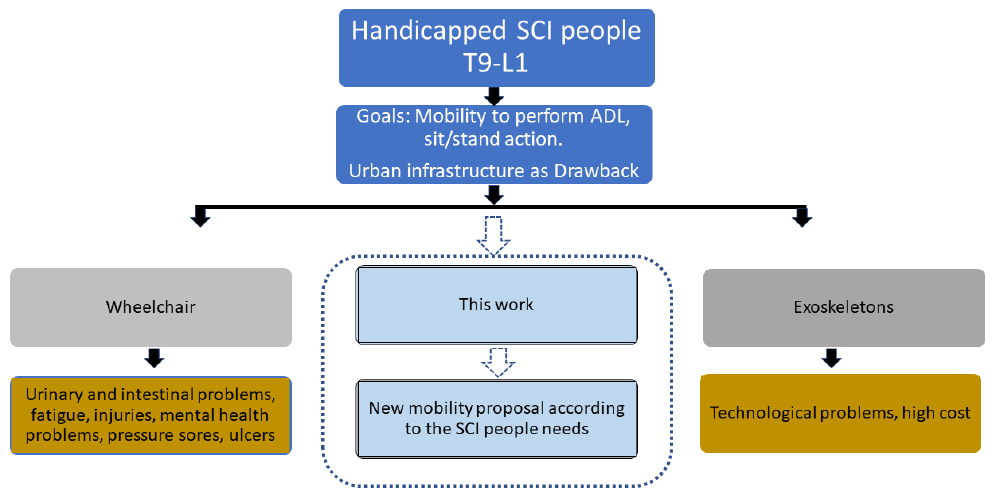
Figure 1. Block diagram problem derived from the